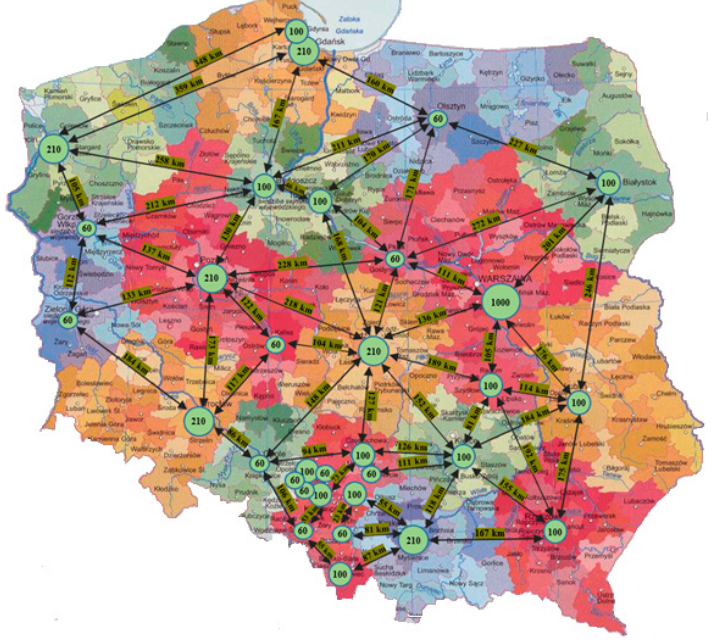
Figure 7. Minimum number of public charging points and distance between municipalities where they are to be located according to the Act of January 11, 2018 on Electromobility and Alternative Fuels. The largest distance between such communes is 359 km (Gda´nsk-Szczecin) and the smallest 10 km